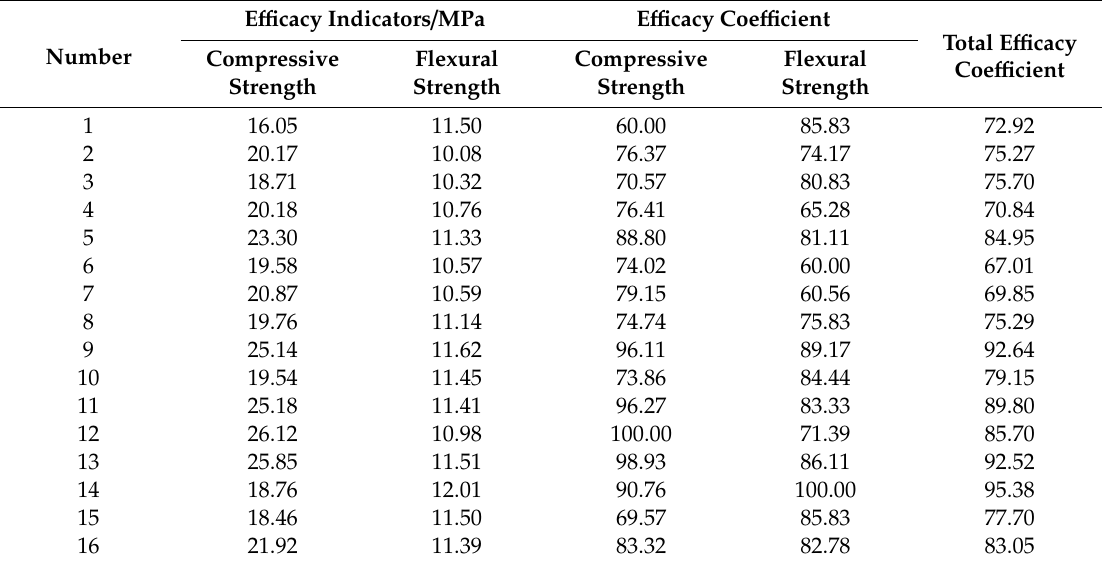
Table 11. E ffi cacy Coe ffi cient Analysis